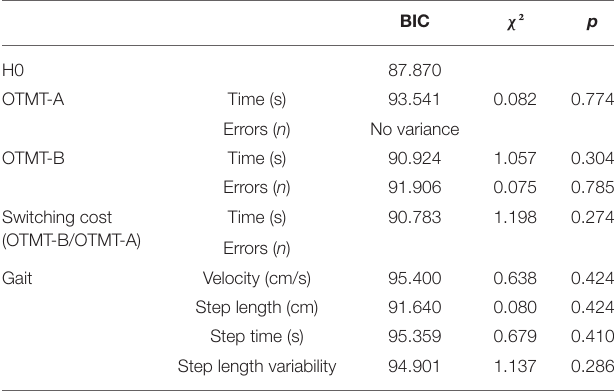
TABLE 4 | Characteristics of the logistic regression model of cognitive and gait performances under ST conditions.